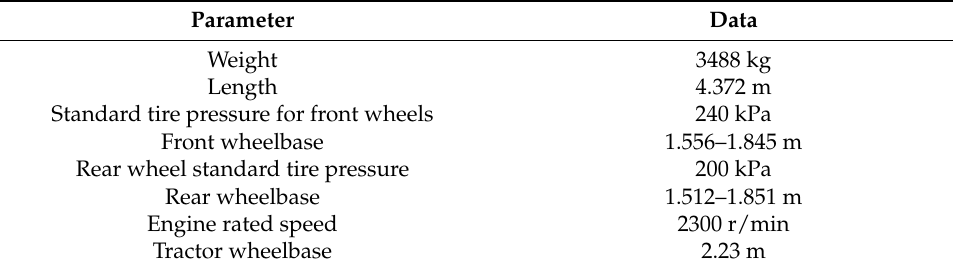
Figure 1. Test site and vehicle. Table 1. Tractor parameters.